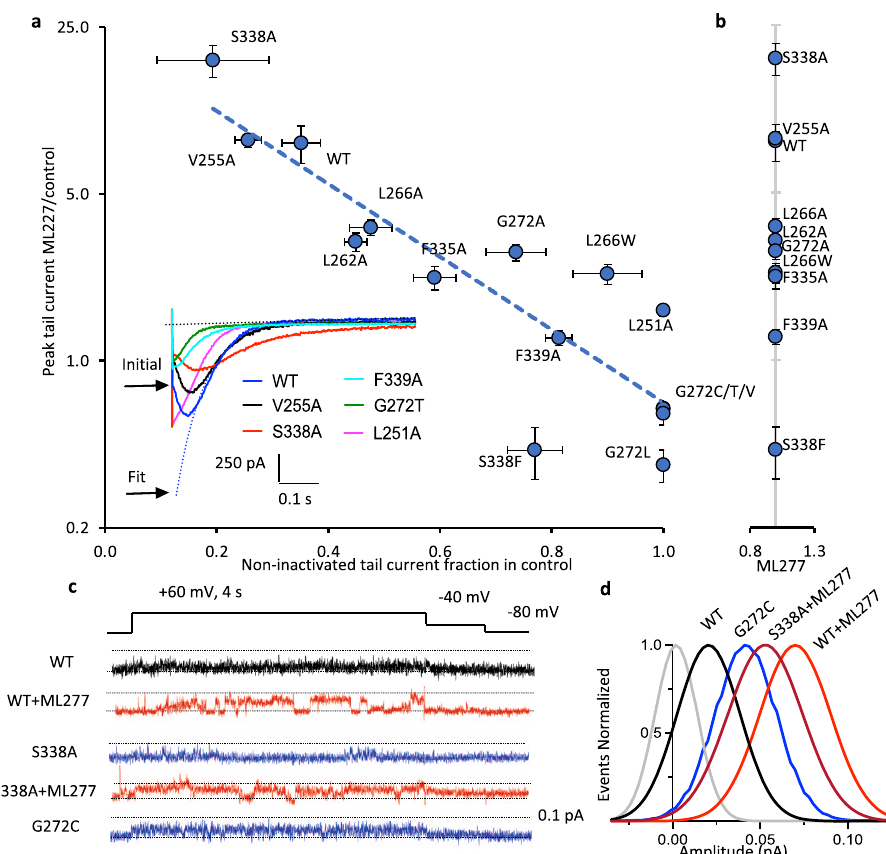
Fig. 8 Tail current increase in ML277 vs. inactivation of KCNQ1 mutants is re fl ected in single channels. a Tail current response to ML277, data from Fig. 7c, on a log ordinate vs non-inactivated tail current fraction in the absence of ML277 (see inset) from Fig. 7e. Fitted correlation r s = − 0.86, P = 0.0001, Spearman rank coef fi cient. Linear trend line is shown. Inset panel shows control tail currents at − 120 mV for WT and stated mutants. As an example, the initial peak of the WT tail (blue) is indicated, and also the fi t back to the tail start to extract the fi tted peak value. Values represent the mean ± SEM, n values as for Fig. 7c and e. b As for panel a except non-inactivated fraction was obtained in the presence of 1 μ M ML277. L251A and G272C/T/L/V were unchanged from control solution (panel a ) and for clarity are not replotted. Note that in some cases vertical and horizontal error bars fall within plotted symbols. c Voltage protocol and representative single-channel recordings of WT, S338A, and G272C KCNQ1 in control and 1 μ M ML277 as indicated. Data fi ltered at 2 kHz at acquisition, and 200 Hz for presentation. Dotted lines denote zero pA (baseline) and 0.1 pA. No ML277 data were obtained for G272C. d Gaussian fi ts of amplitude event distributions for a blank sweep (gray), WT, S338A, and G272C sweeps, in control and ML277 as indicated. For WT, peaks were 0.02 in control, and 0.069 ± 0.003 pA in ML277, n = 4 cells. For S338A, peaks were 0.022± 0.002 in control (not shown) and 0.049 ± 0.003 pA in ML277, n = 3 cells. For G272C peaks were 0.040 ± 0.002 pA in control, n = 3